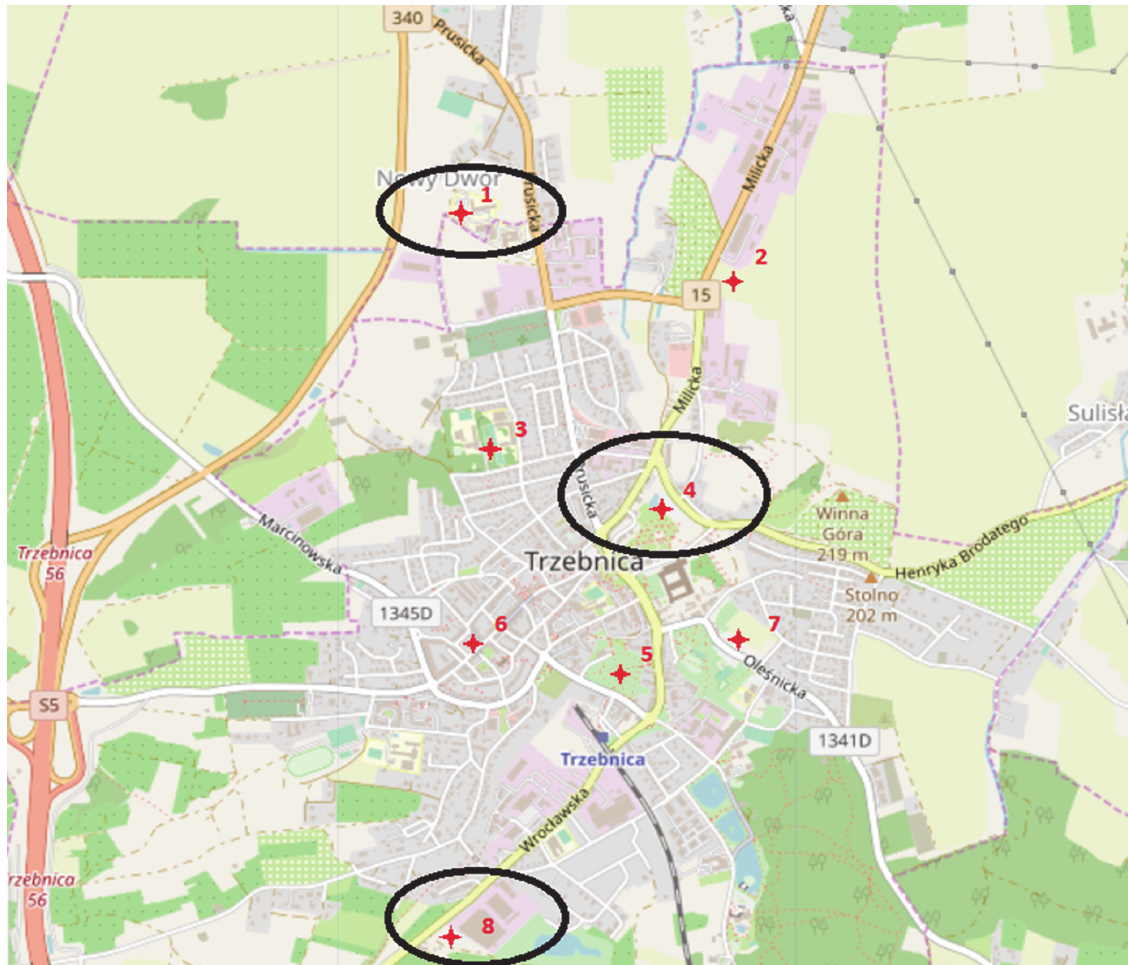
Fig. 6. Available locations of landing zones (red crosses) with marked in black chosen